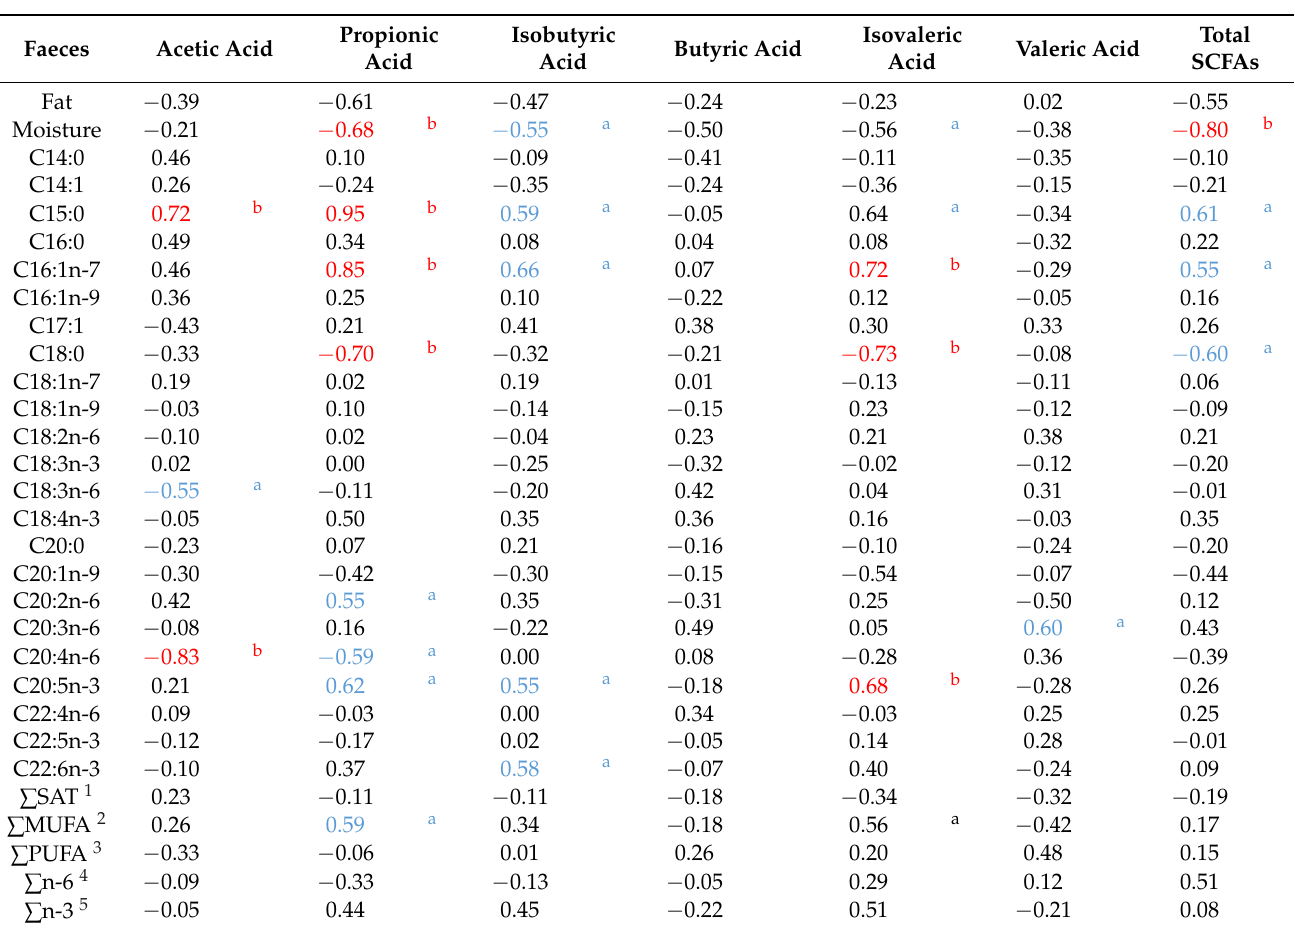
Table 5. Correlation coefficients between short-chain fatty acids (SCFAs) and the fatty acid profile in